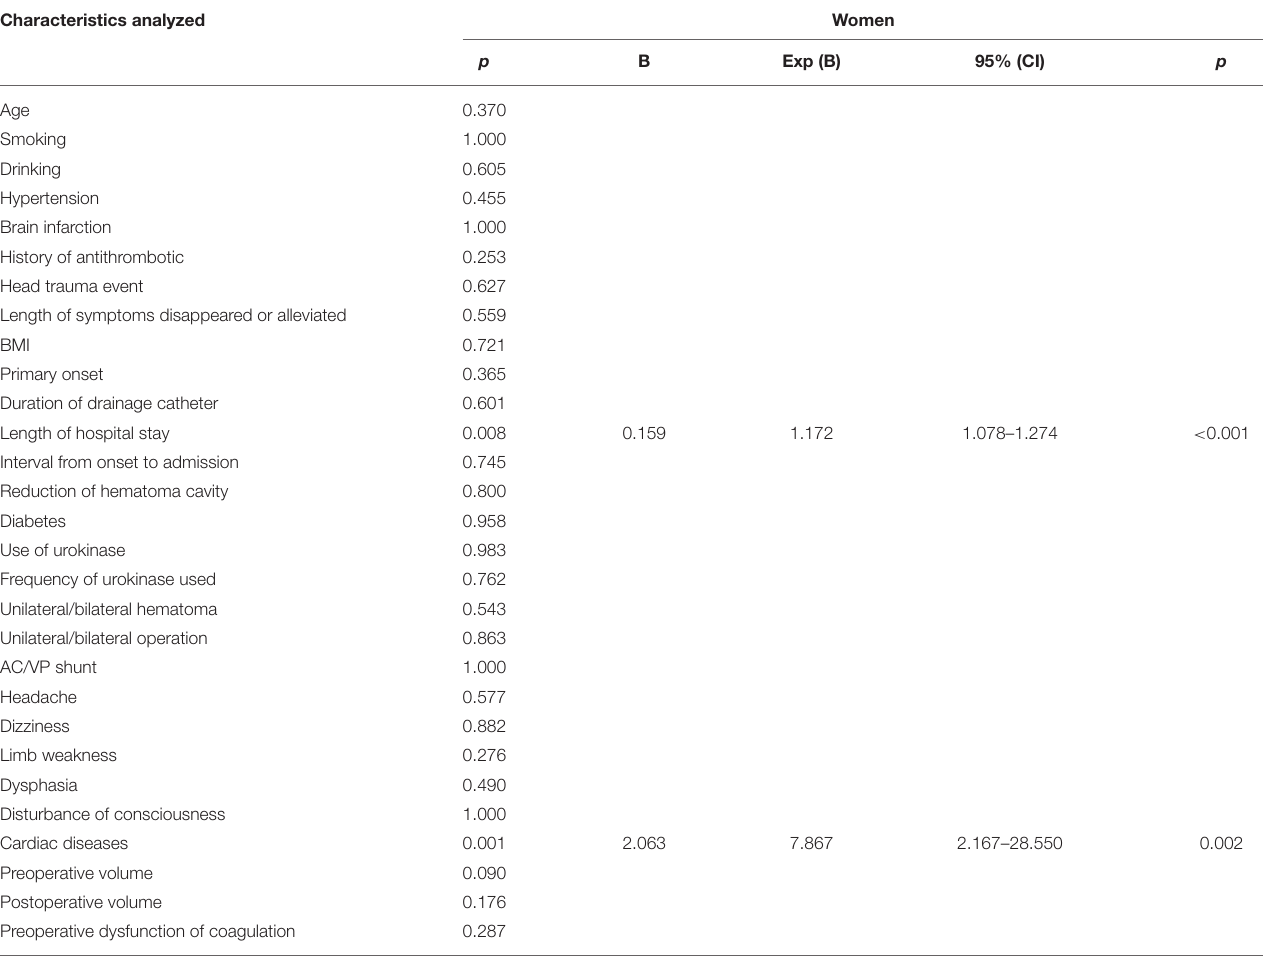
TABLE 4 | Logistic regression analyses of characteristics related to complications in women patients with chronic subdural hematoma. Characteristics analyzed